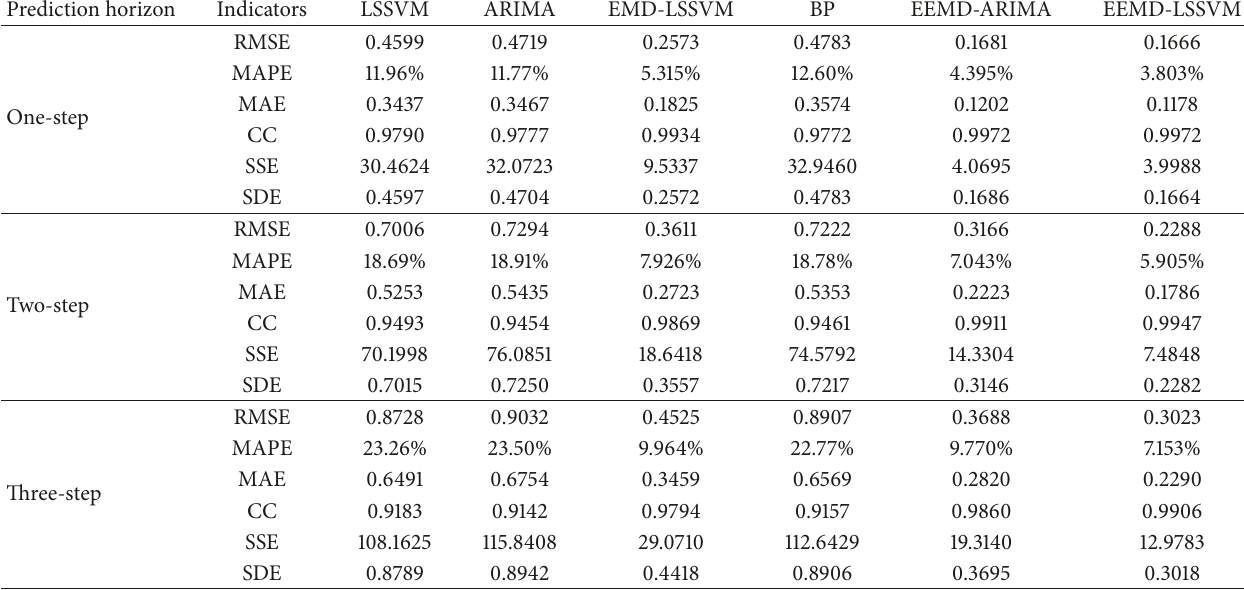
Table 6: Performance comparison of different models for forecasting wind speed (Case